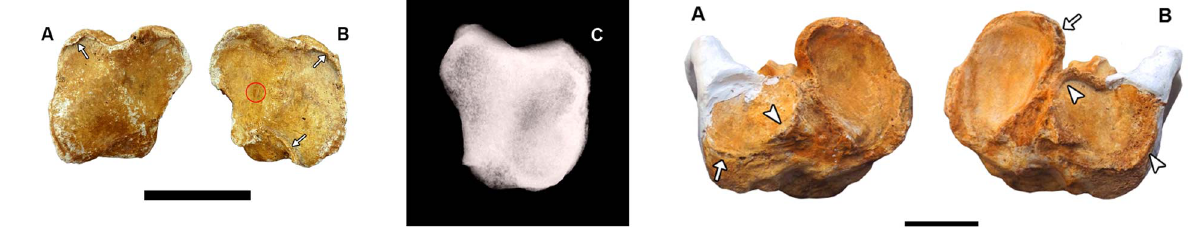
Figure 6. Tibiae-fibulae of Glyptotherium . (A) Right tibia-fibula MCC 1561-V in proximal view; (B) Left tibia-fibula MCC 1515-V in proximal view. The arrows indicate bone erosion, and arrowheads indicate osteophytes. Scale bar = 5 cm.